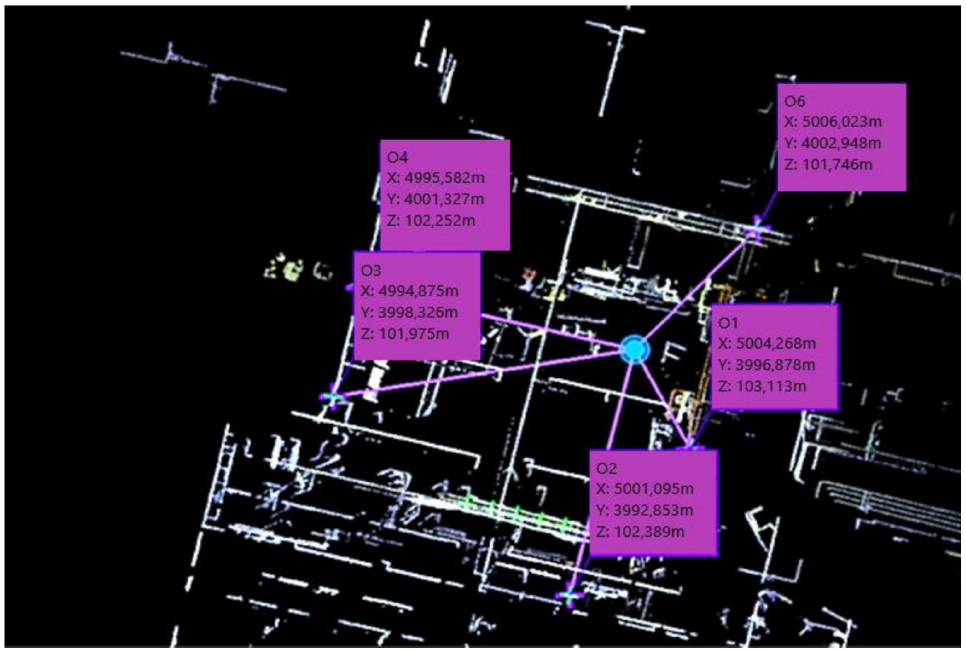
Figure 5. Georeferencing and input of support points when measuring the beam TL_01.